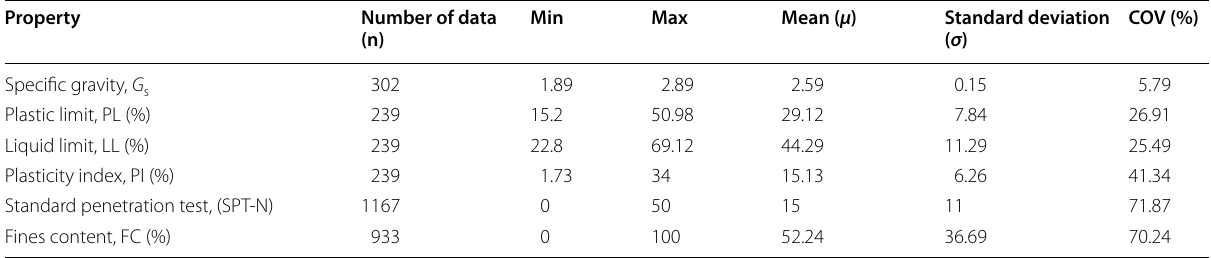
Table 1 A statistical overview of the geotechnical properties of Kathmandu Valley soils